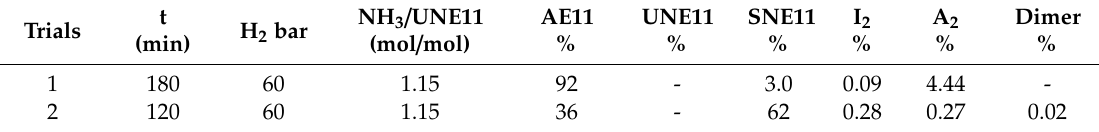
Table 1. Influence of reaction time on the hydrogenation of UNE11. Reaction conditions: 60